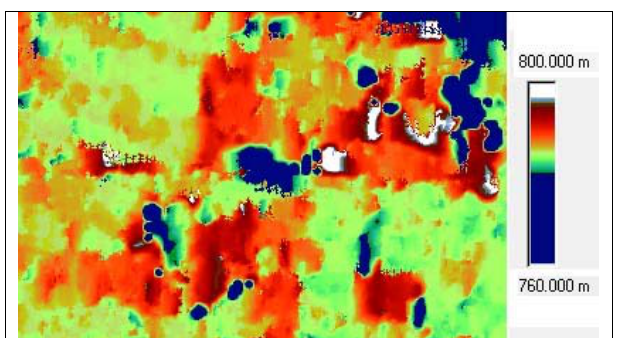
Figure 24: Colour coded DSM by LSM Aerial stereo model 63cm GSD